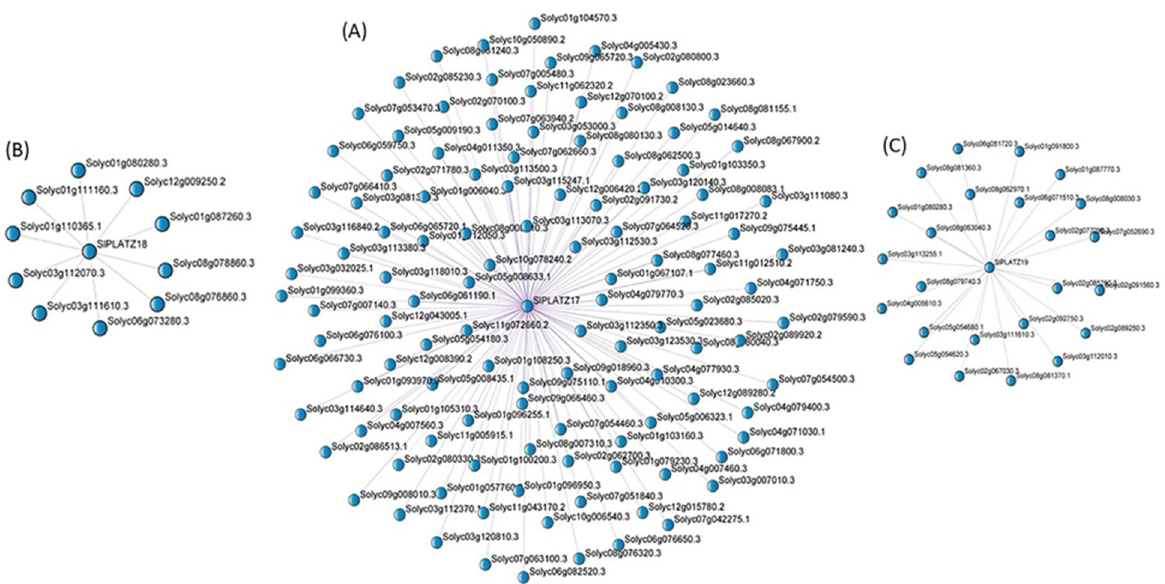
Figure 8. Gene co-expression network analysis of SlPLATZ genes. The co-expressed genes identified in the networks of SlPLATZ17 ( A ), SlPLATZ 18 ( B ), and SlPLATZ19 ( C ).